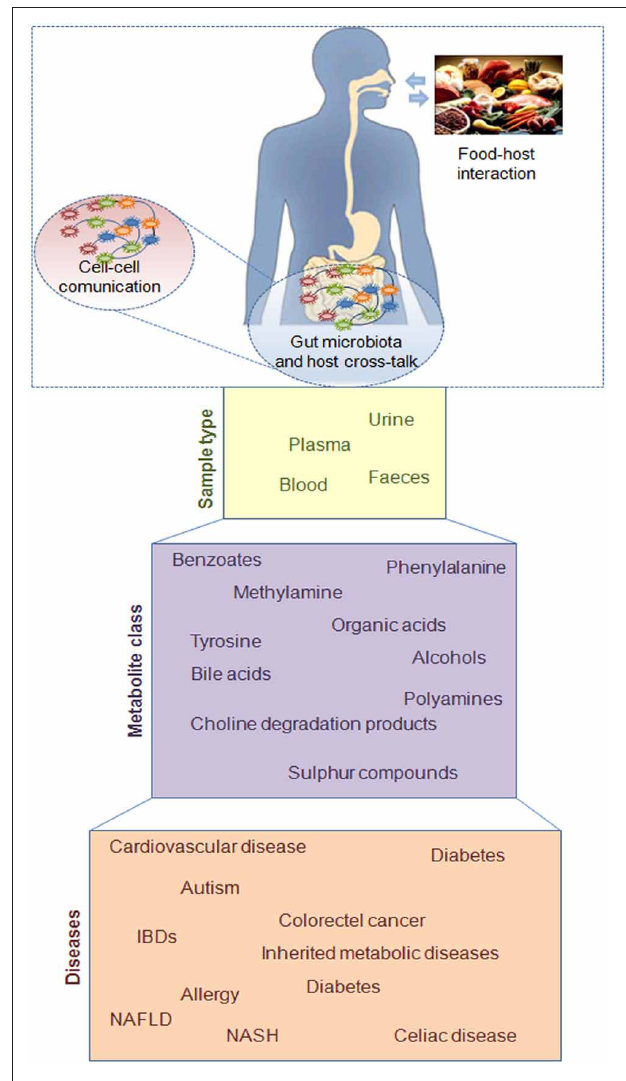
FIGURE 1 | Schematic representation of diet, microbes, and host interaction at gut level. The chemical dialogue via low molecular weight metabolites, peptides, and proteins between cell-cell and host-microbes leads to the metabolite production in different body fluids which could be considered as disease